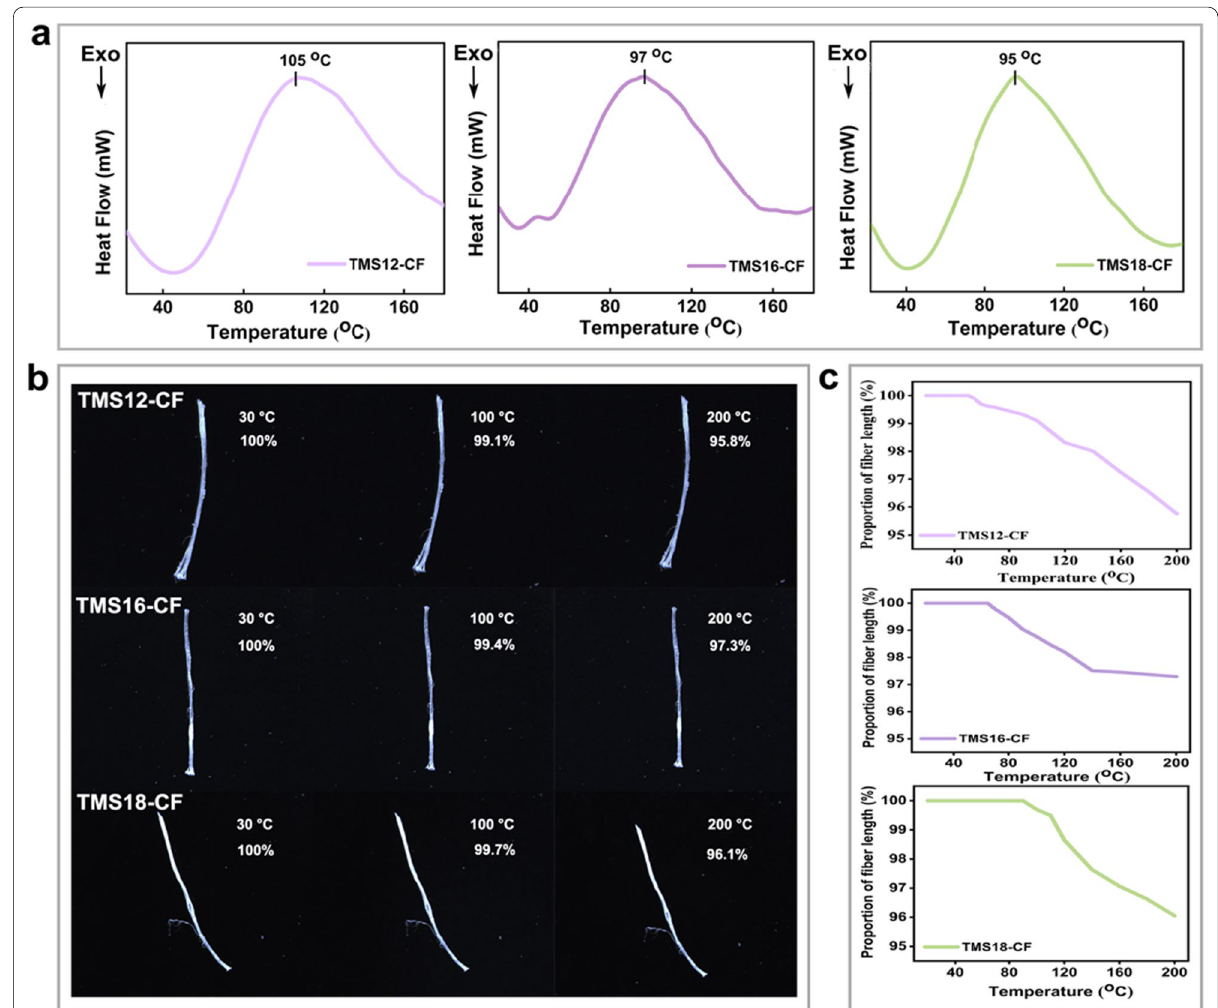
Fig. 5 DSC curves of TMSx-CF ( a ), digital photos of TMSx-CF at different temperatures ( b ), the length percentage of the TMSx-CF at different temperatures ( c